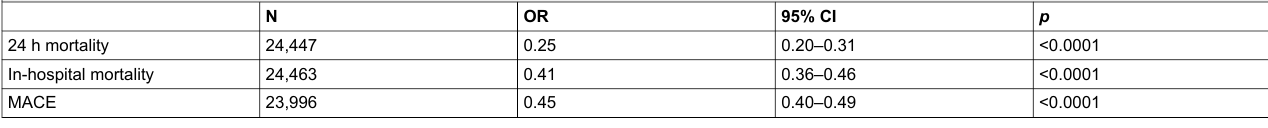
Table 2b: Effect of early clopidogrel treatment, adjusted for age, gender and STEMI. N